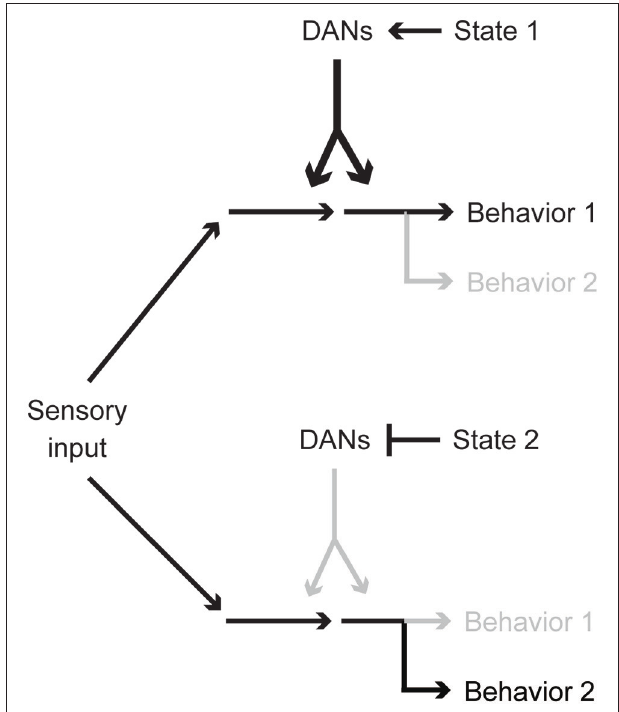
FIGURE 4 | Activity pattern of a single DAN population biases behavioral choice. Particular behavioral responses are preferred when certain combinations of DAN types are spontaneously active. DAN activity reflects the physiological and psychological state of an animal and optimizes behaviors.